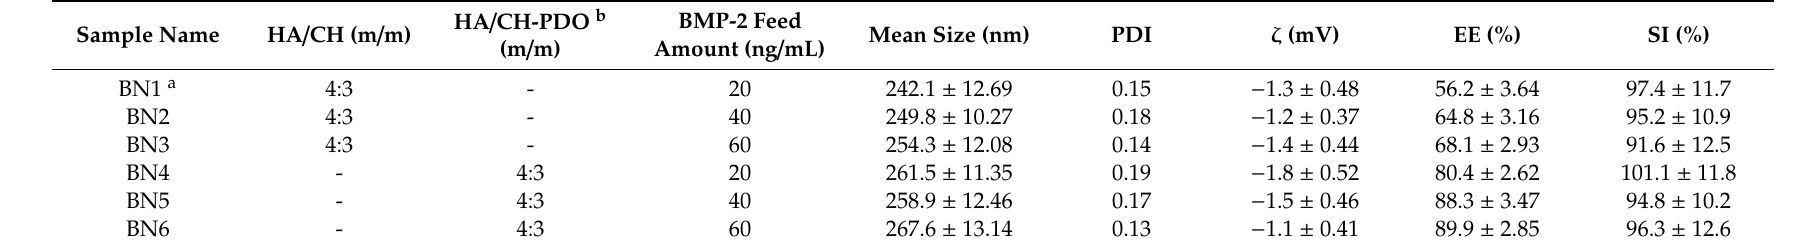
Table 2. Parameters of BMP-2-encapsulated nanoparticles.